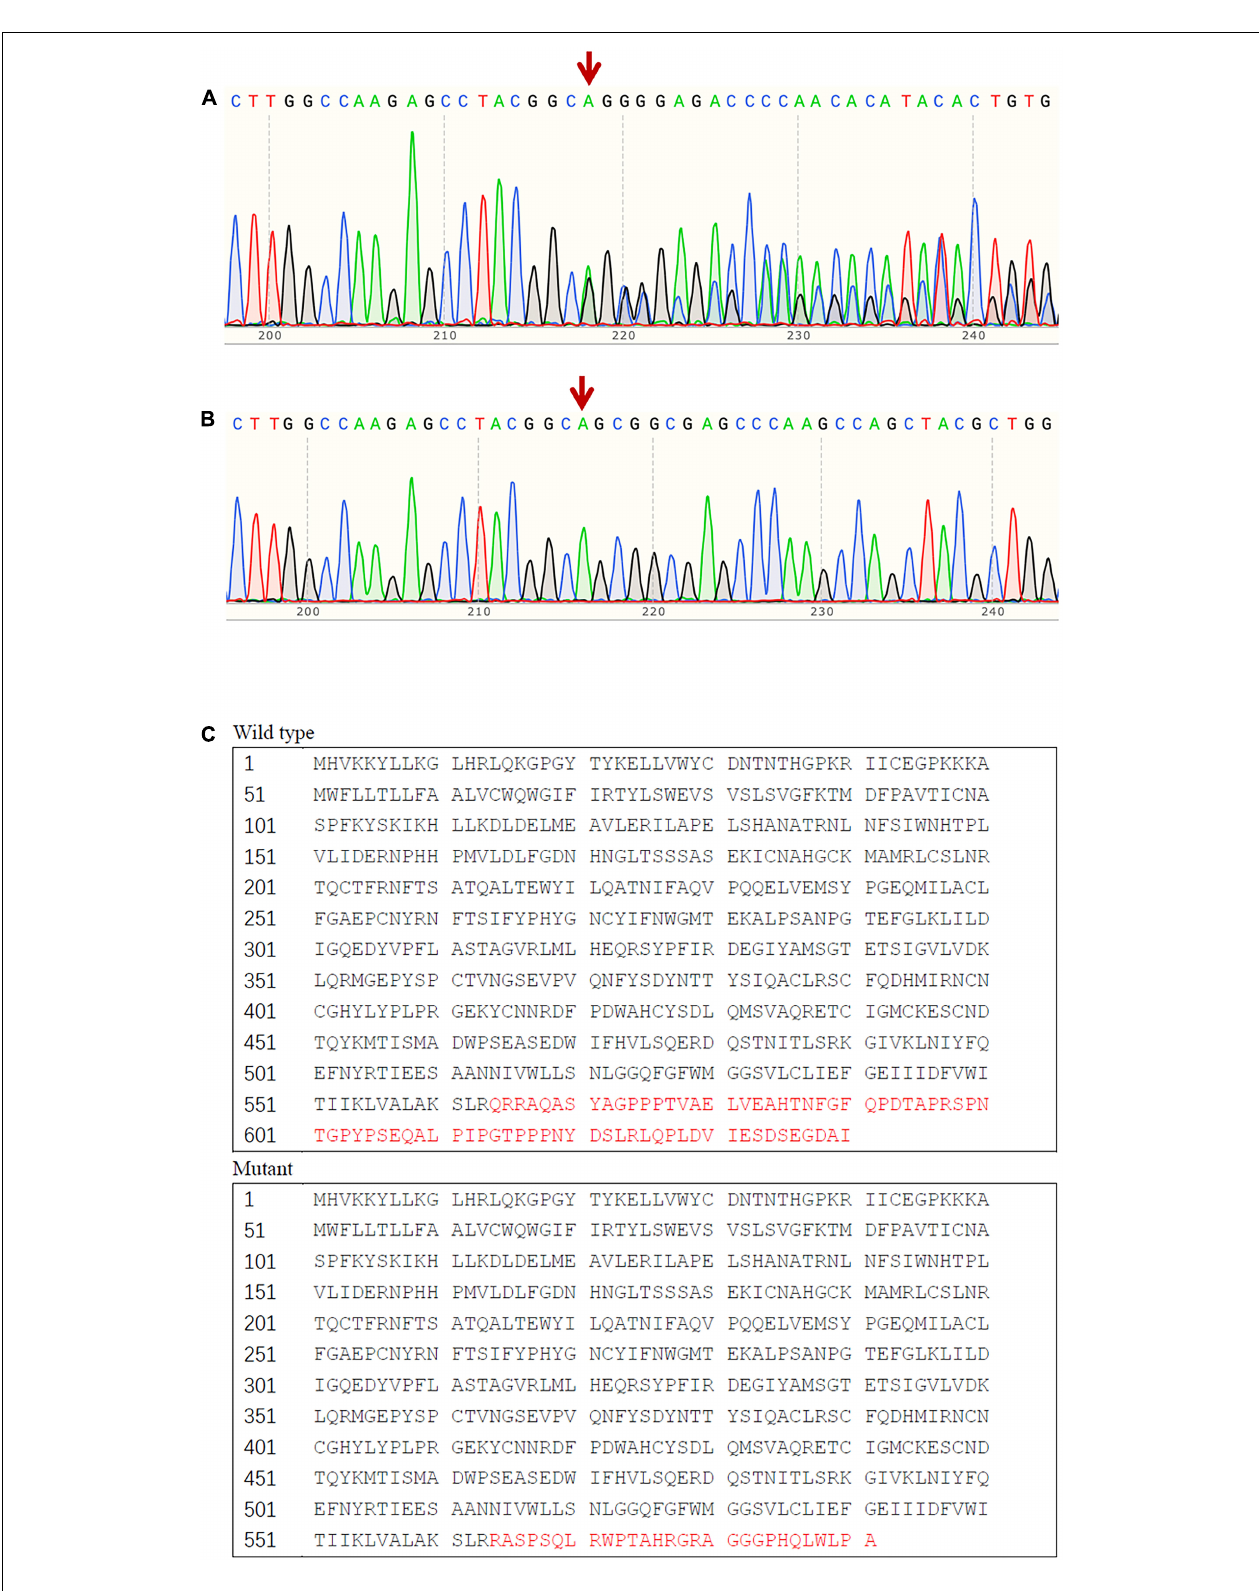
FIGURE 2 | Sequence analysis result of exon 13 of SCNN1B . (A) The frame-shift mutation (c.1691_1693delinsG) identified in affected patients with Liddle syndrome; (B) corresponding normal sequence in unaffected subjects; (C) predicted alteration of the protein sequence due to the mutant SCNN1B .